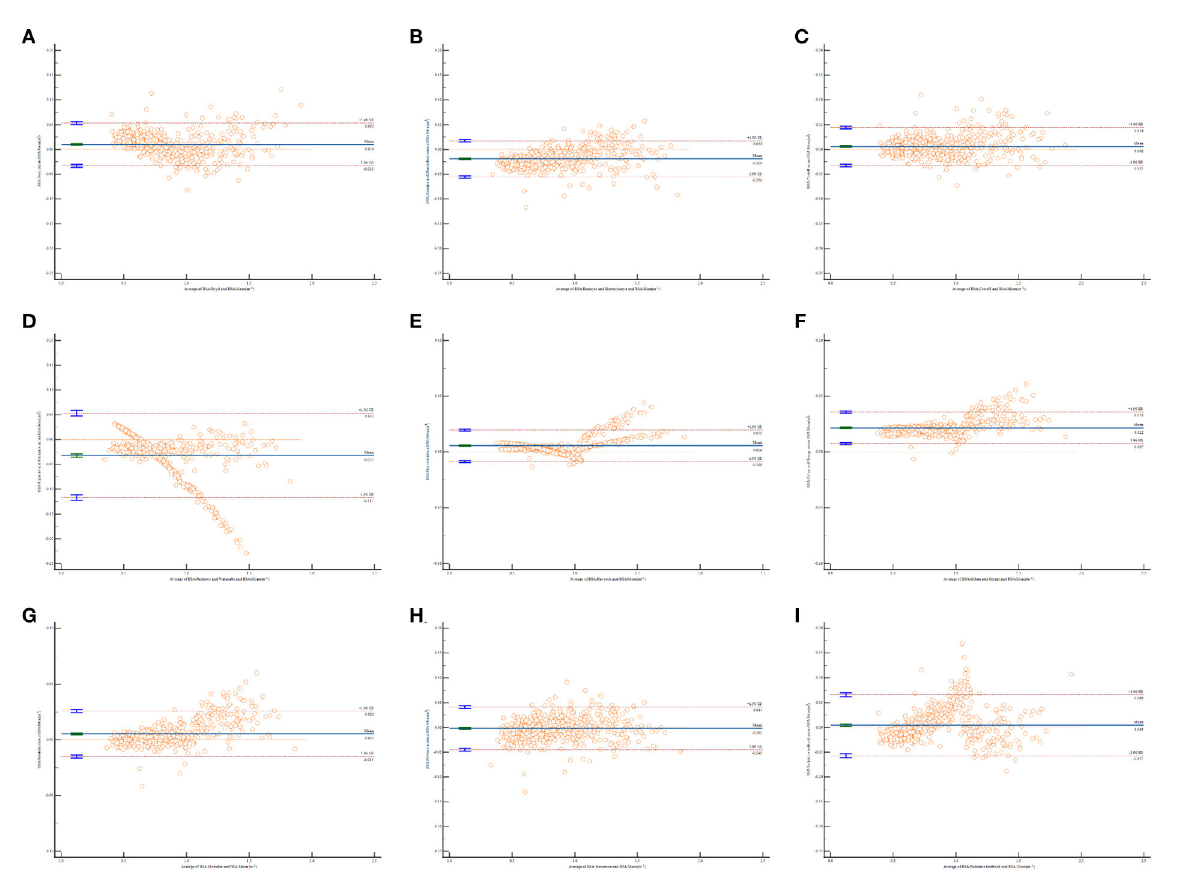
FIGURE1 Bland and Altman plots of the differences in body surface area (BSA) values calculated by different formulas against the mean BSA values. The horizontal x-axis shows the average of BSA calculated by each formula and mean BSA, AND THE vertical y-axis shows the D-value of BSA calculated by each formula and mean BSA. (A) BSA calculated by Boyd formula vs. the mean BSA values; (B) BSA calculated by Banerjee and Bhattacharya formula vs. the mean BSA values; (C) BSA calculated by Costeff formula vs. the mean BSA values; (D) BSA calculated by Fujimoto and Watanabe formula vs. the mean BSA values; (E) BSA calculated by Haycock formula vs. the mean BSA values; (F) BSA calculated by Gehan and George formula vs. the mean BSA values; (G) BSA calculated by Mosteller formula vs. the mean BSA values; (H) BSA calculated by Stevenson formula vs. the mean BSA values; (I) BSA calculated by Pediatrics textbook formula vs. the mean BSA